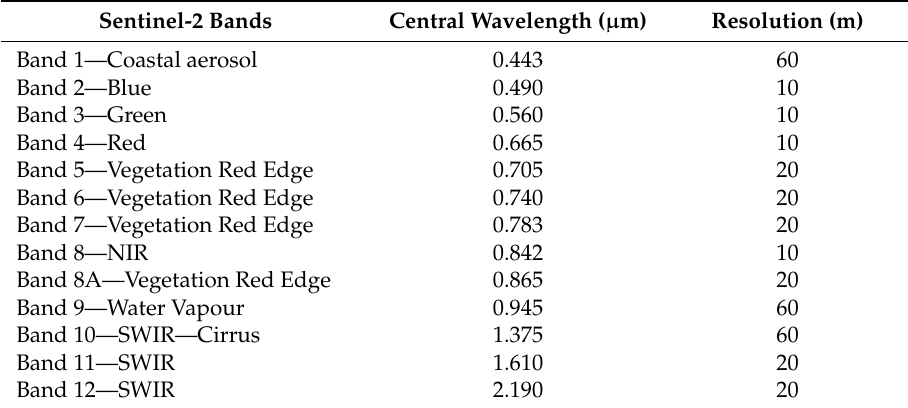
Table 1. Sentinel-2 bands with the corresponding central wavelengths and spatial resolution. Sentinel-2 Bands Central Wavelength ( µ